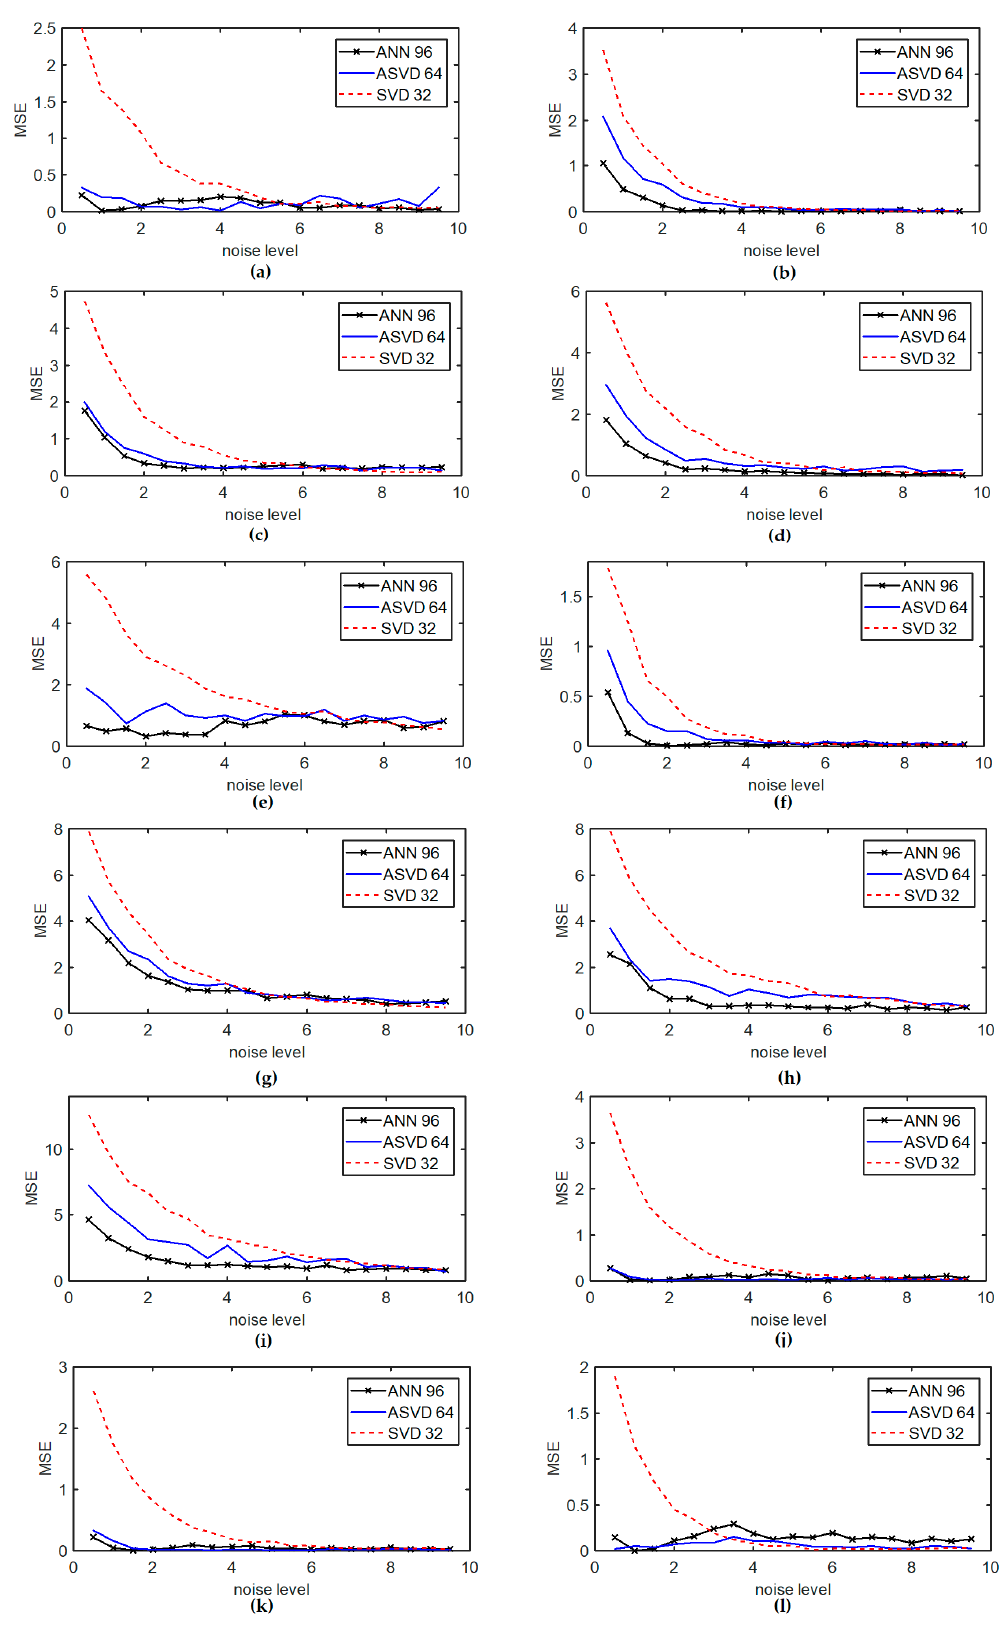
Figure 6. The MSE levels for different block-based noise level estimation algorithms in the SVD domain and for different test images: ( a ) Car, ( b ) Lena, ( c ) Town, ( d ) Couple, ( e ) Einstein, ( f ) Girlface, ( g ) Goldhill, ( h ) Pirate, ( i ) Blonde woman, ( j ) Barbara, ( k ) Boat, and ( l ) Crowd.